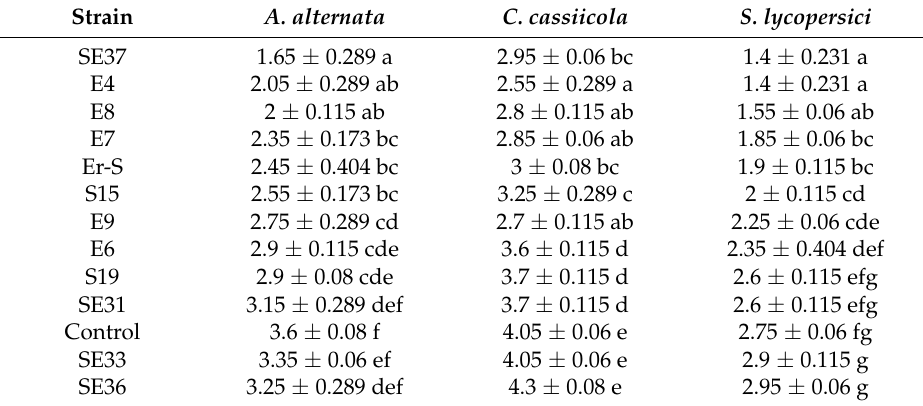
Table 4. Determination quantitative of the antagonist effect in the growth of fungi. Values from the same column followed by a letter in common are not significantly different according to Tukey’s test at p ≤ 0.05.